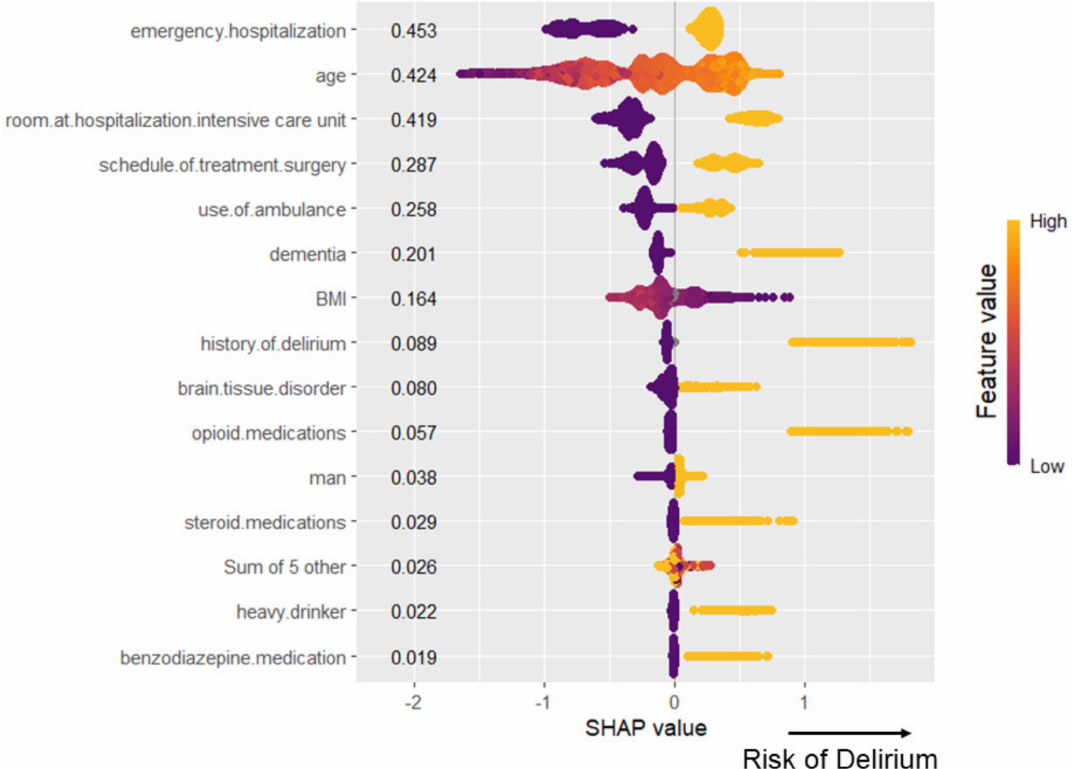
Figure 2. SHAP summary plot for Population A. SHAP summary plot of a 14-predictor XGBoost model. Each dot denotes a patient. Although there are 14 predictors, the one-hot encoding process results in 19 features when inputting into the XGBoost model. The top 15 predictive contributing features are shown. The x-axis shows the SHAP value attributed to the predictors. Higher SHAP values represent higher risk of delirium due to